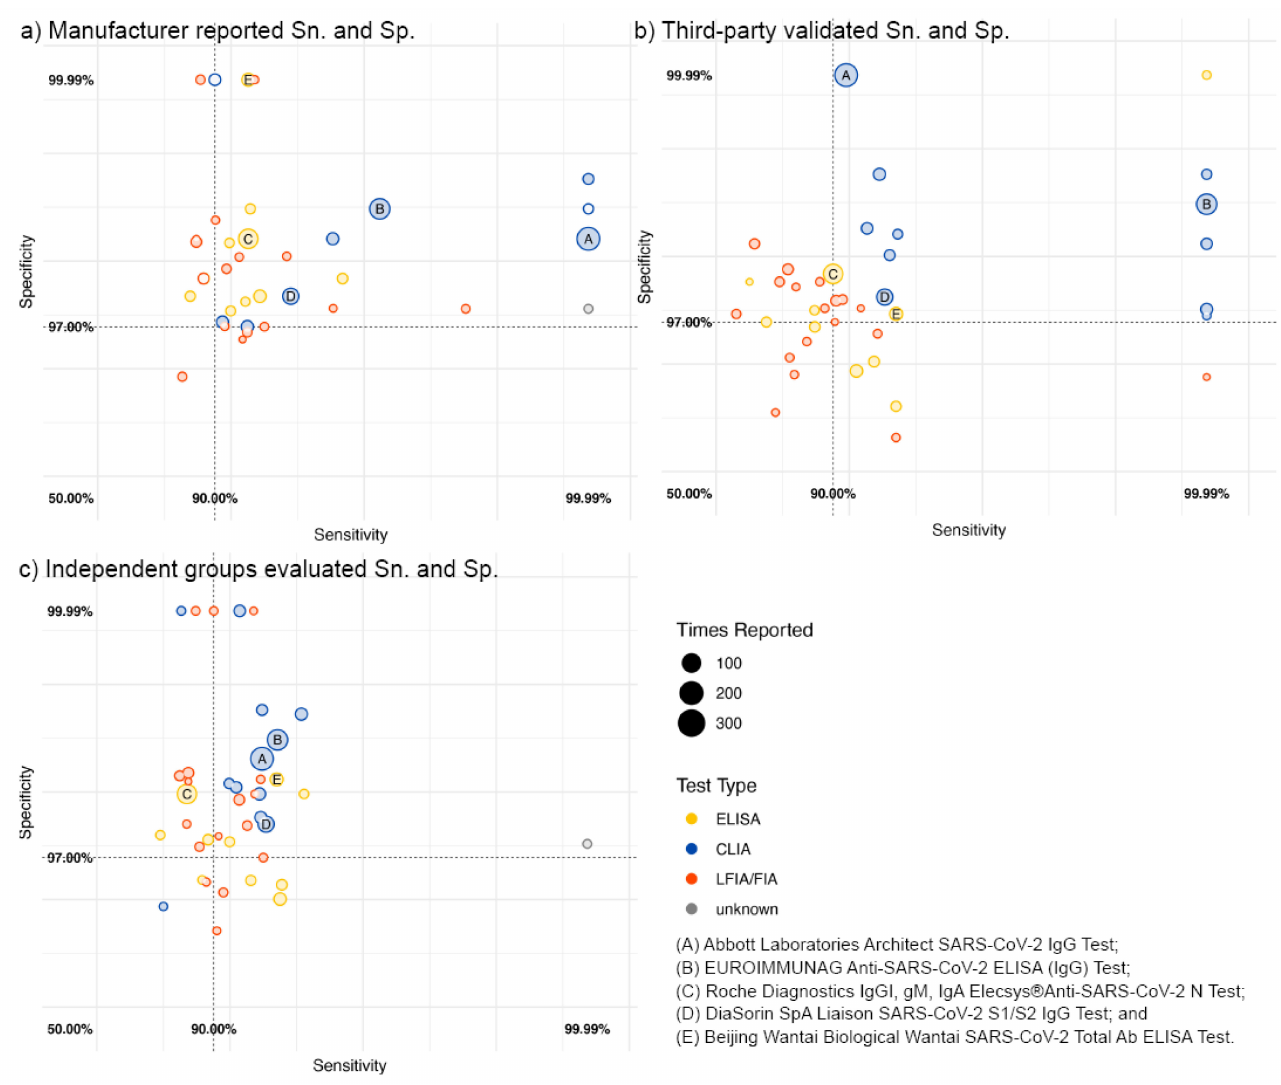
Figure 2. Sensitivity and specificity based on ( a ) manufacturer, ( b ) third-party, and ( c ) independent group evaluations for the top 50 most frequently used commercial serological assays. Note: both axes are on a log scale. Assays missing the corresponding source of evaluation were not involved in the analysis. The vertical and the horizontal lines indicate the WHO thresholds for Emergency Use Authorizations for COVID-19 serological assays: sensitivity minimum of 90.0%, and specificity minimum of 97.0%, respectively. Assays on the upper right area of each panel meet the WHO criteria for emergency use based on the dataset in